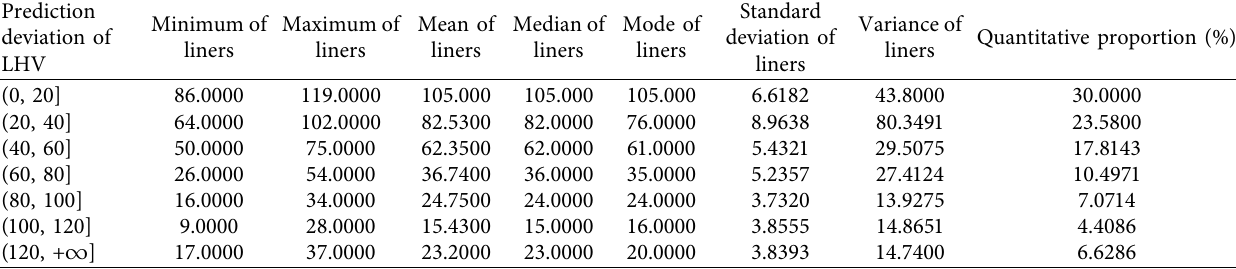
Table 4: Prediction deviation profile of LHV with FEB-LCR-ACM by LHV-SIX (unit: TEU).